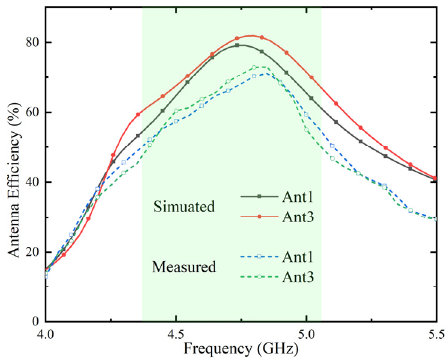
Figure 13. Simulated and measured. ( a ): Reflection coefficients and ( b ): transmission coefficients of MIMO antenna system.